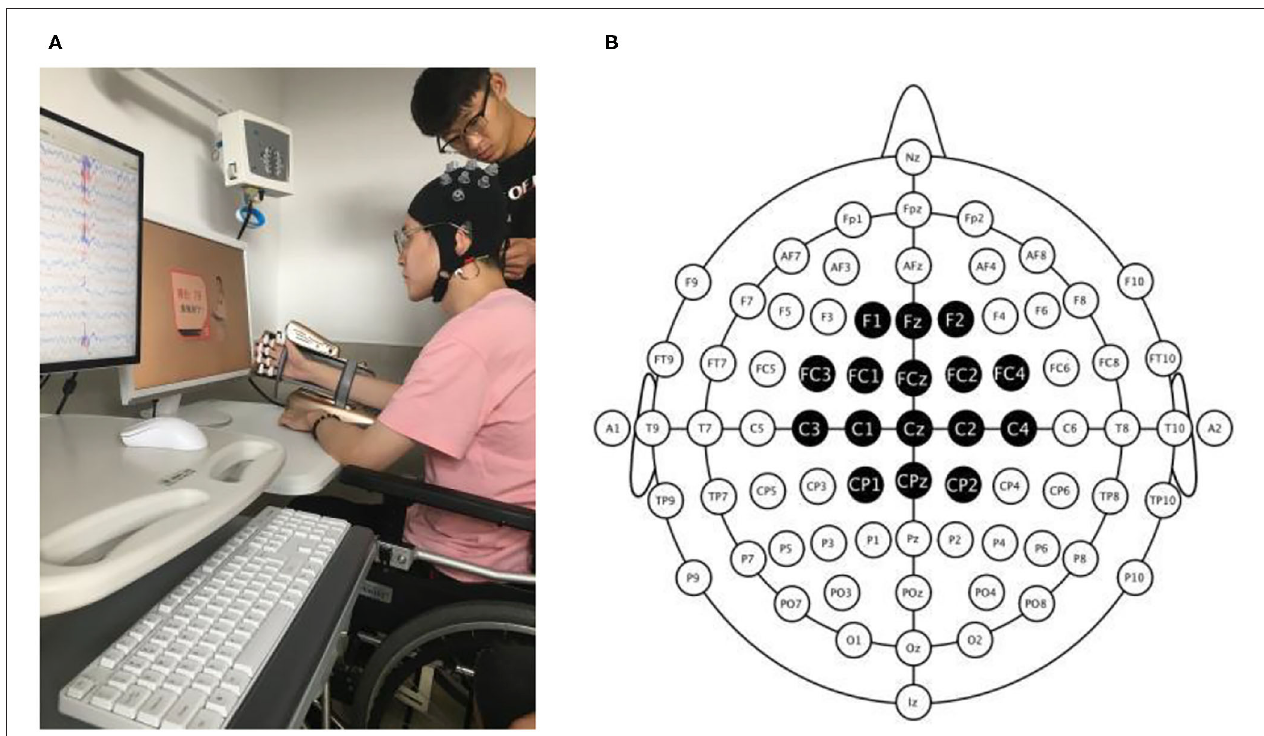
FIGURE 2 | Photograph of the BCI-robot training system. (A) The whole system includes an EEG amplifier collecting real-time EEG, a PC processing EEG signal providing visual and auditory feedback, and a triggered-robot hand supporting sensory and movement feedback. (B) The montage of real-time EEG electrodes. There were 16 active electrodes placed on the frontal and parietal